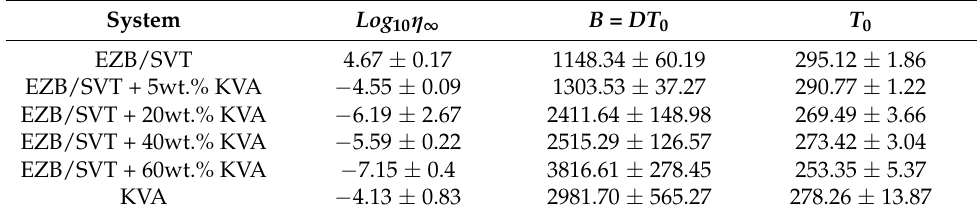
Table 2. Comparison of the VFT fitting parameters for neat KVA, the binary mixture of EZB/SVT, and ternary systems of EZB/SVT/KVA containing 5, 20, 40 and 60wt. % of the